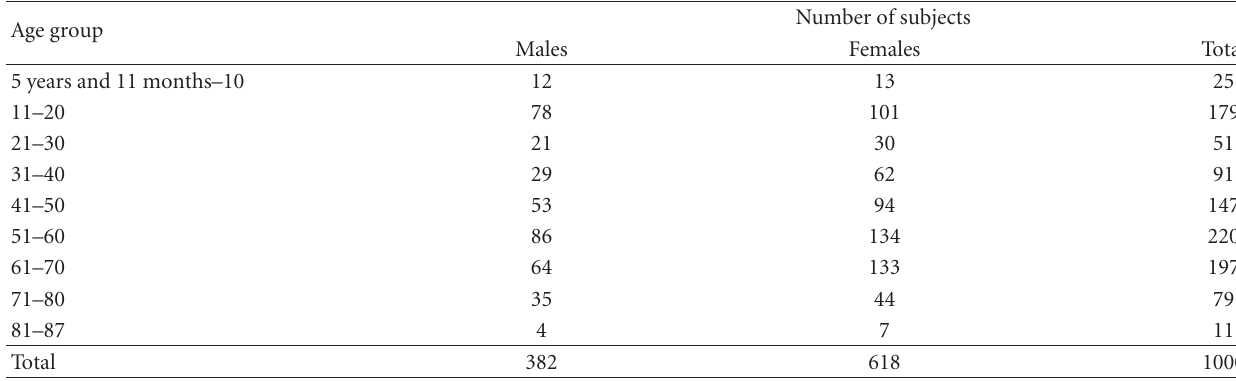
Table 1: Age and Sex distribution of subjects.